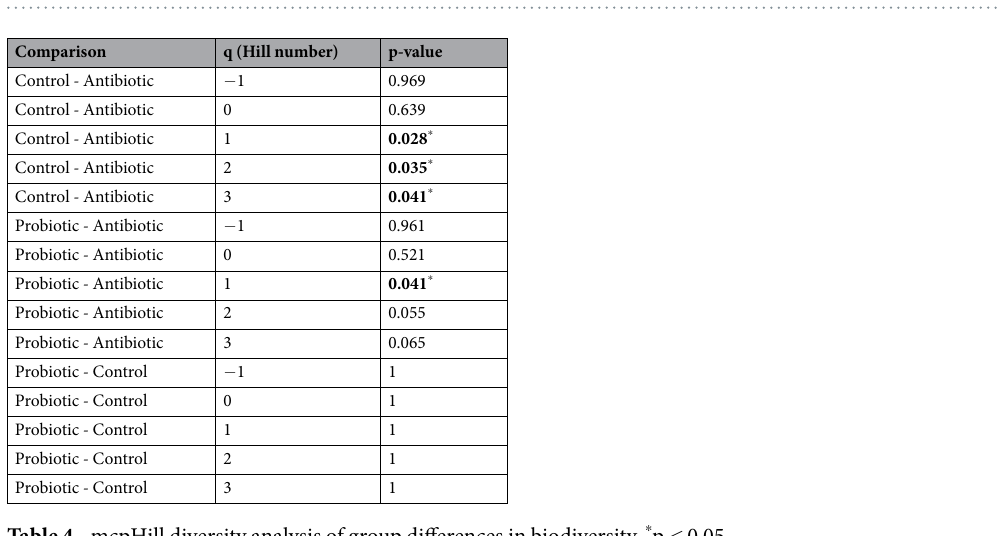
Figure 5. Total species richness obtained by the ( a ) Chao 1 index (ANOVA significance of p = 0.22), the ( b ) Shannon’s diversity index (ANOVA significance of p = 0.02) and the ( c ) richness index (ANOVA significance of p = 0.216) for cecal bacterial communities of broilers from the different treatment group (i.e. multi-strain probiotic, antibiotic combination and untreated).